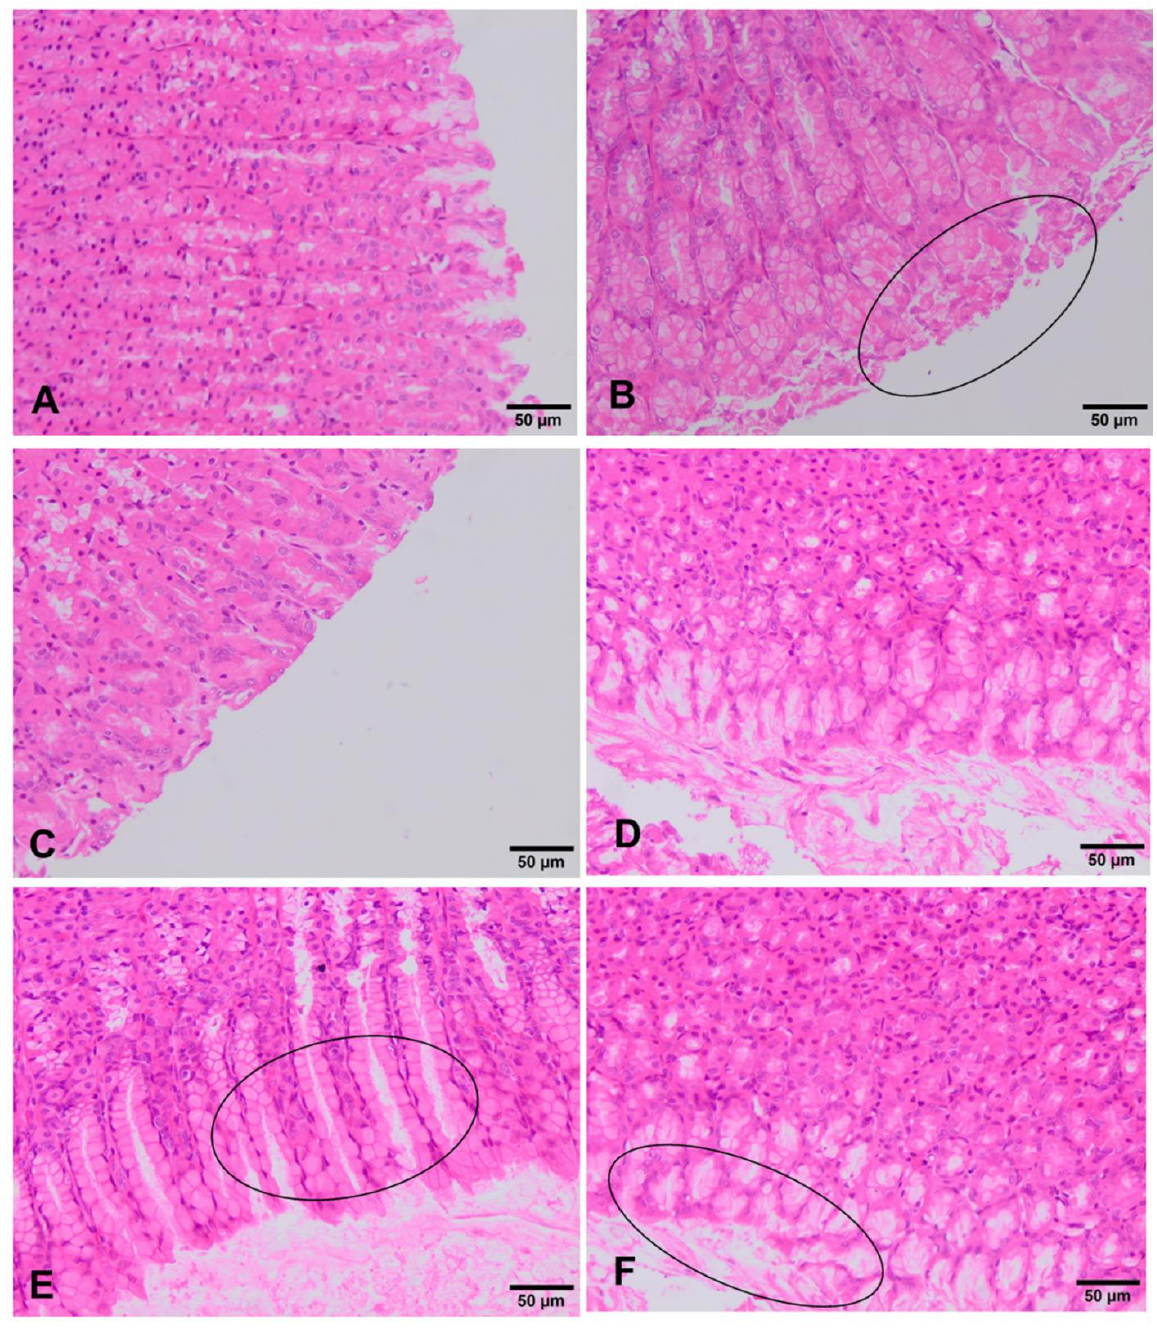
Figure 4. Histopathological changes in the stomach of rats exposed to ST-99. Apparently normal gastric mucosa is observed in negative control group ( A ). In positive control rats ( B ) gastric mucosa with processes of desquamative necrotic gastritis (circle) are observed. Rats exposed to 90 mg/kg ST-99 showed an apparently normal gastric mucosa ( C ). Unaltered gastric mucosa are observed in rats treated with 180 mg/kg ST-99 ( D ). Rats exposed to 360 mg/kg ST-99 exhibited desquamative catarrhal gastritis (circle) ( E,F ).